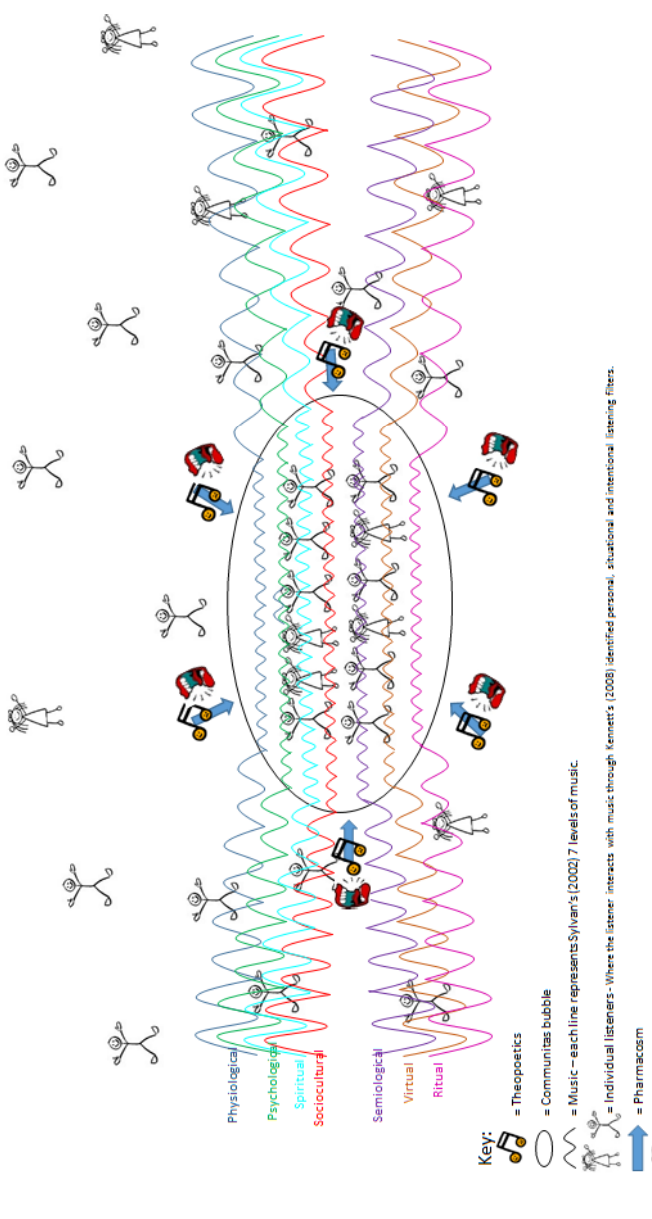
Figure 5. Factors contributing to communitas in a live music setting. 1